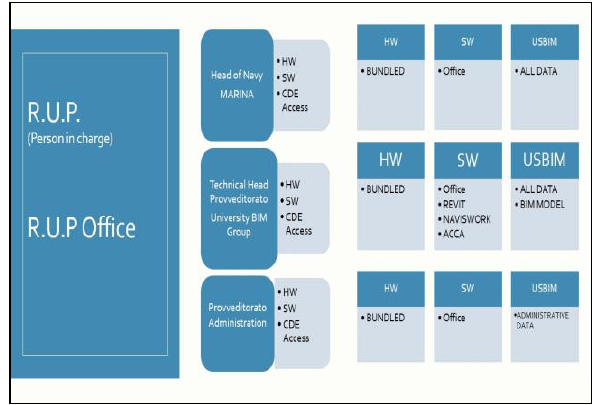
Figure 5 . Professionals’ commitment and software